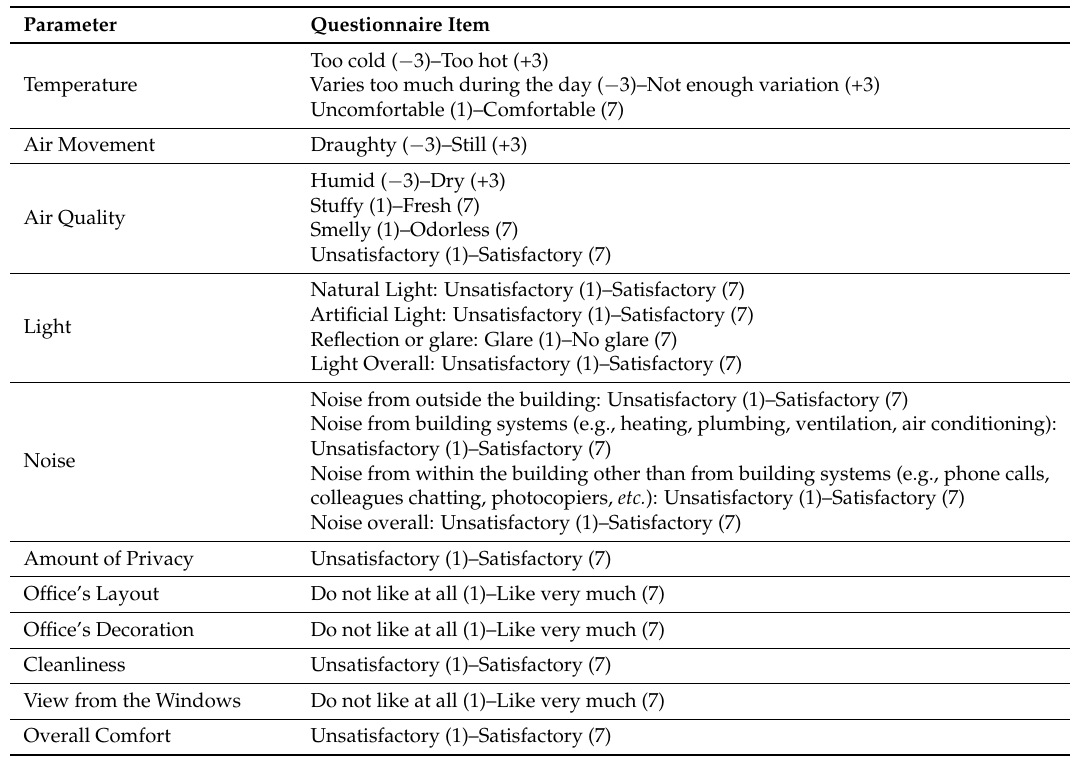
Table 1. List of parameters assessed in the OFFICAIR questionnaire